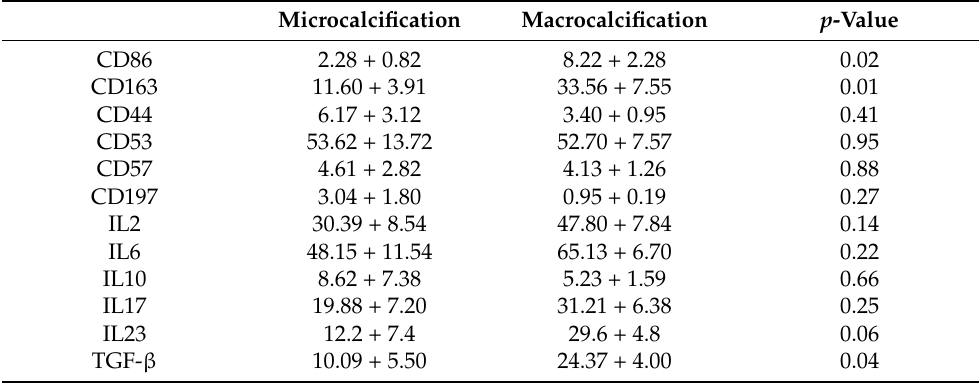
Table 4. Correlation between type of calcification and histological markers of inflammation and